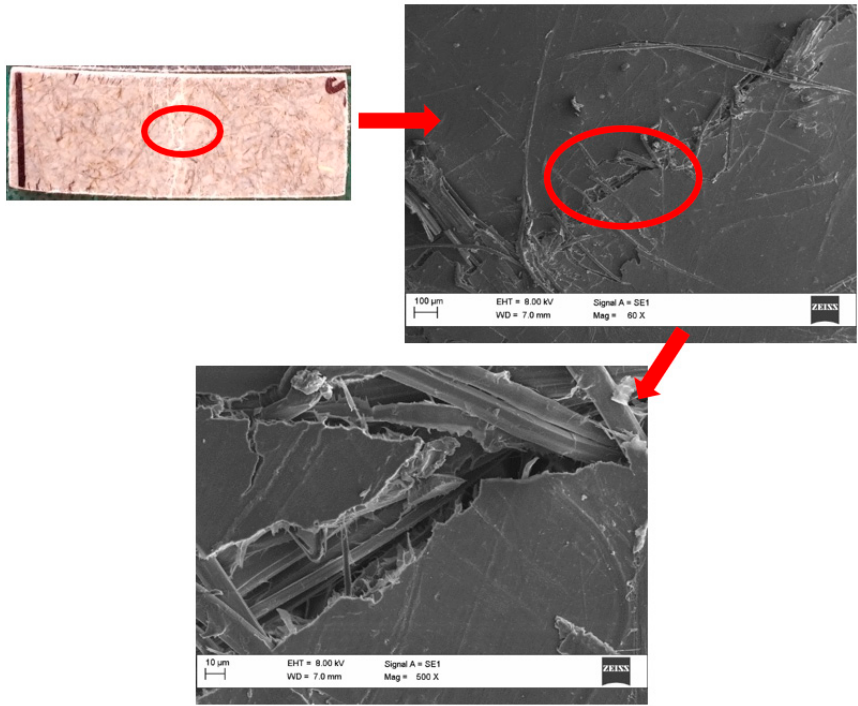
Figure 11. SEM images of the matrix crack of specimen 5-3 in 60× and 500× magnification.